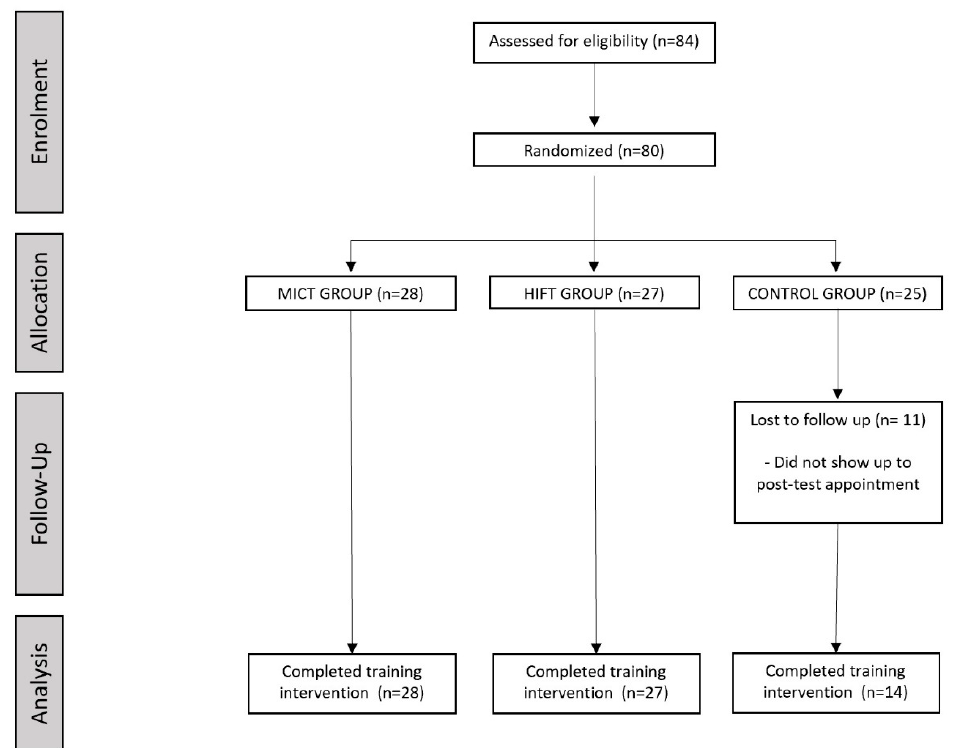
Figure 1. Flow Diagram of